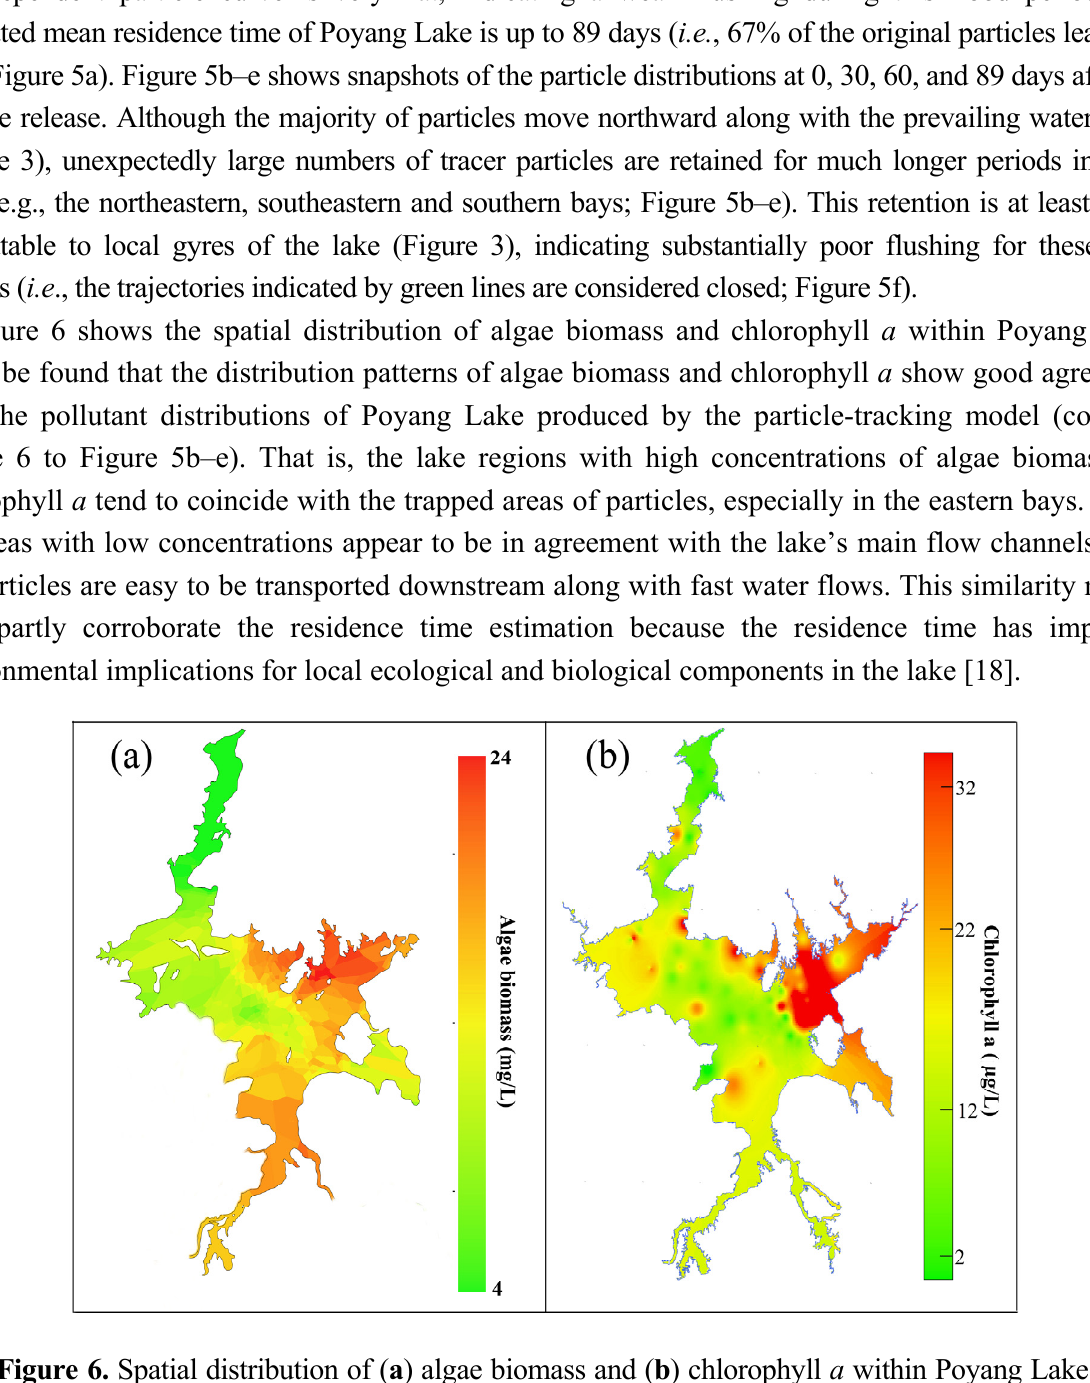
Figure 6. Spatial distribution of ( a ) algae biomass and ( b ) chlorophyll a within Poyang Lake. The algae biomass data were calculated from 83 field sampling sites in July 2012 (black dots) and the figure of chlorophyll a was modified from previous published study